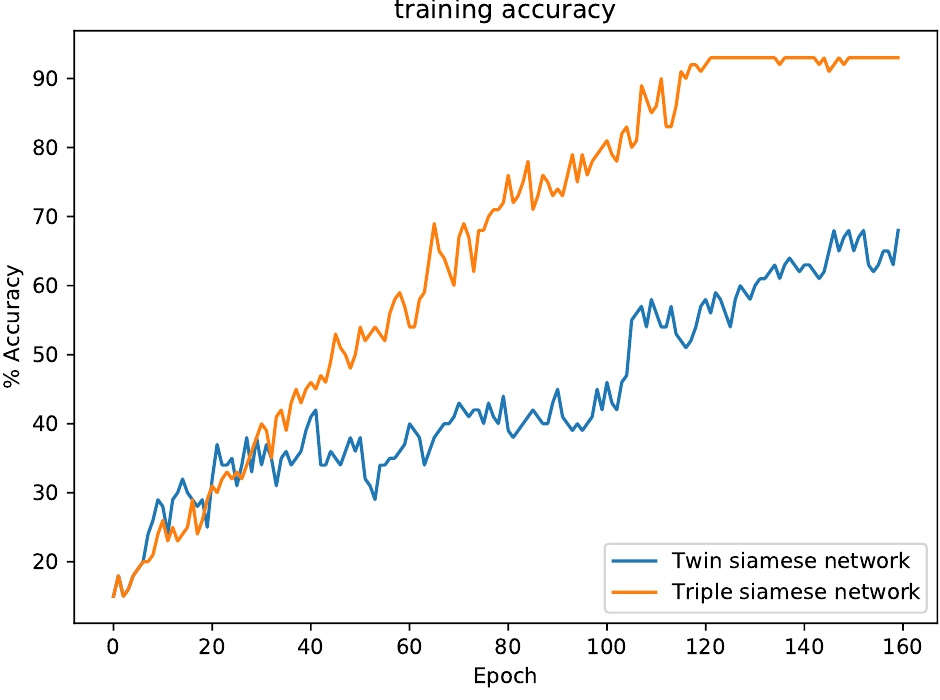
Figure 7. Average training accuracy calculated by performing 2-way one-shot